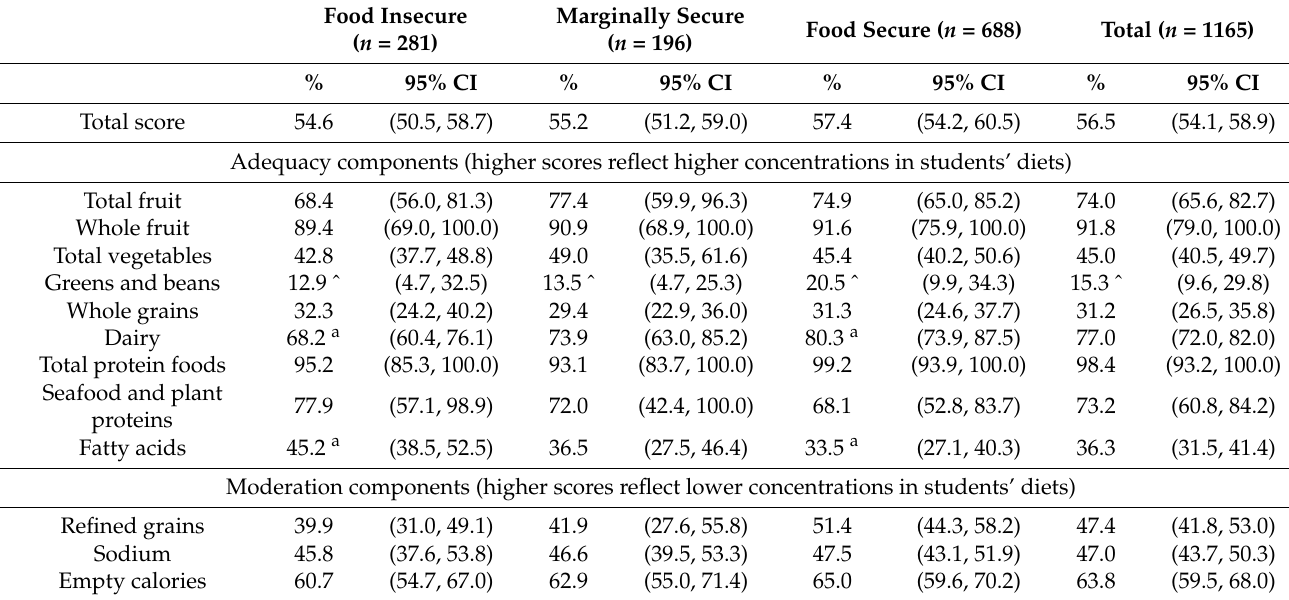
Table 6. HEI-2010 total and component scores, expressed as the mean percentage of the maximum score, for all non-NSLP or SBP foods consumed by school meal participants by food security status 1